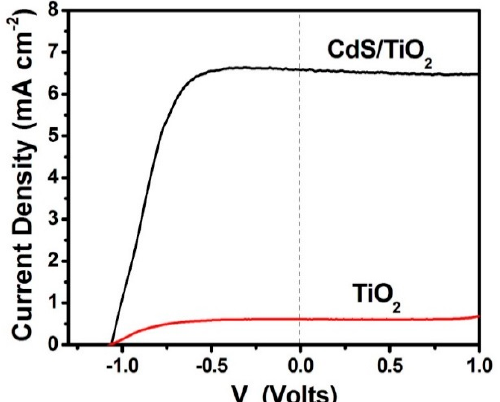
Figure 4. Current density-voltage curves obtained with a PFC functioning in the presence of oxygen. The aqueous electrolyte always contained 0.5 mol·L − 1 NaOH and 5 v % ethanol. Both curves were obtained by illumination with simulated solar radiation. The lower curve corresponds to a photoanode carrying bare titania while the upper curve corresponds to a CdS-sensitized titania photoanode. The curves were traced in a 2-eletrode